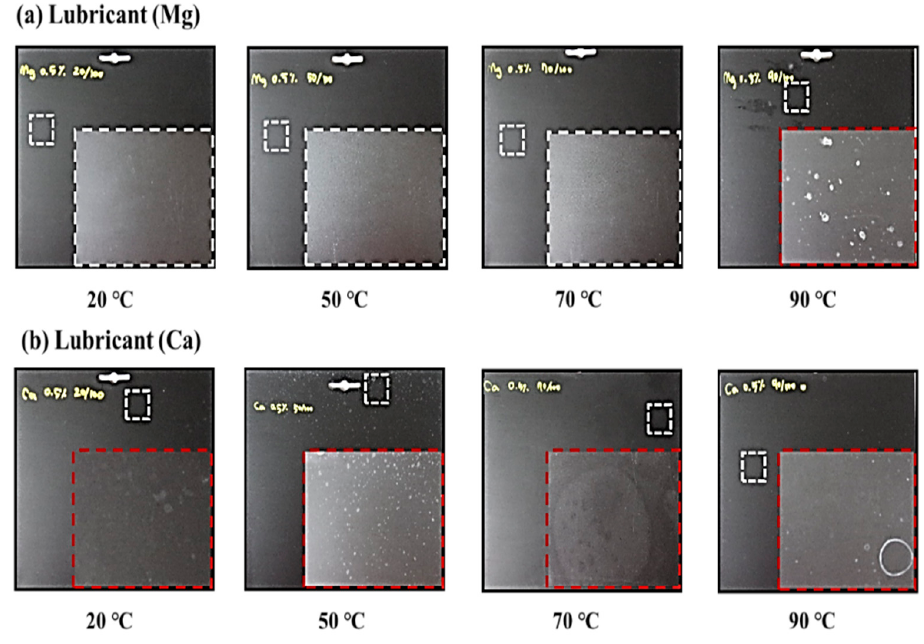
Figure 10. Close-up distal images of polypropylene/lubricants composites thermally aged at different temperatures under 100% humidity: ( a ) PP/Mg; ( b ) PP/Ca.